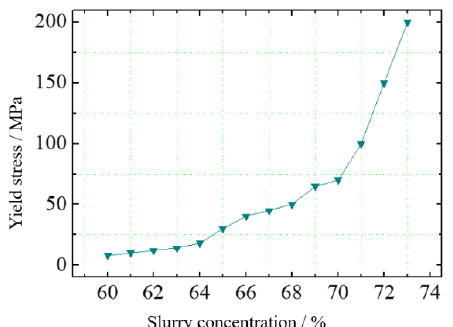
Figure 9. Prediction results of accumulation slope under the influence of concentration.